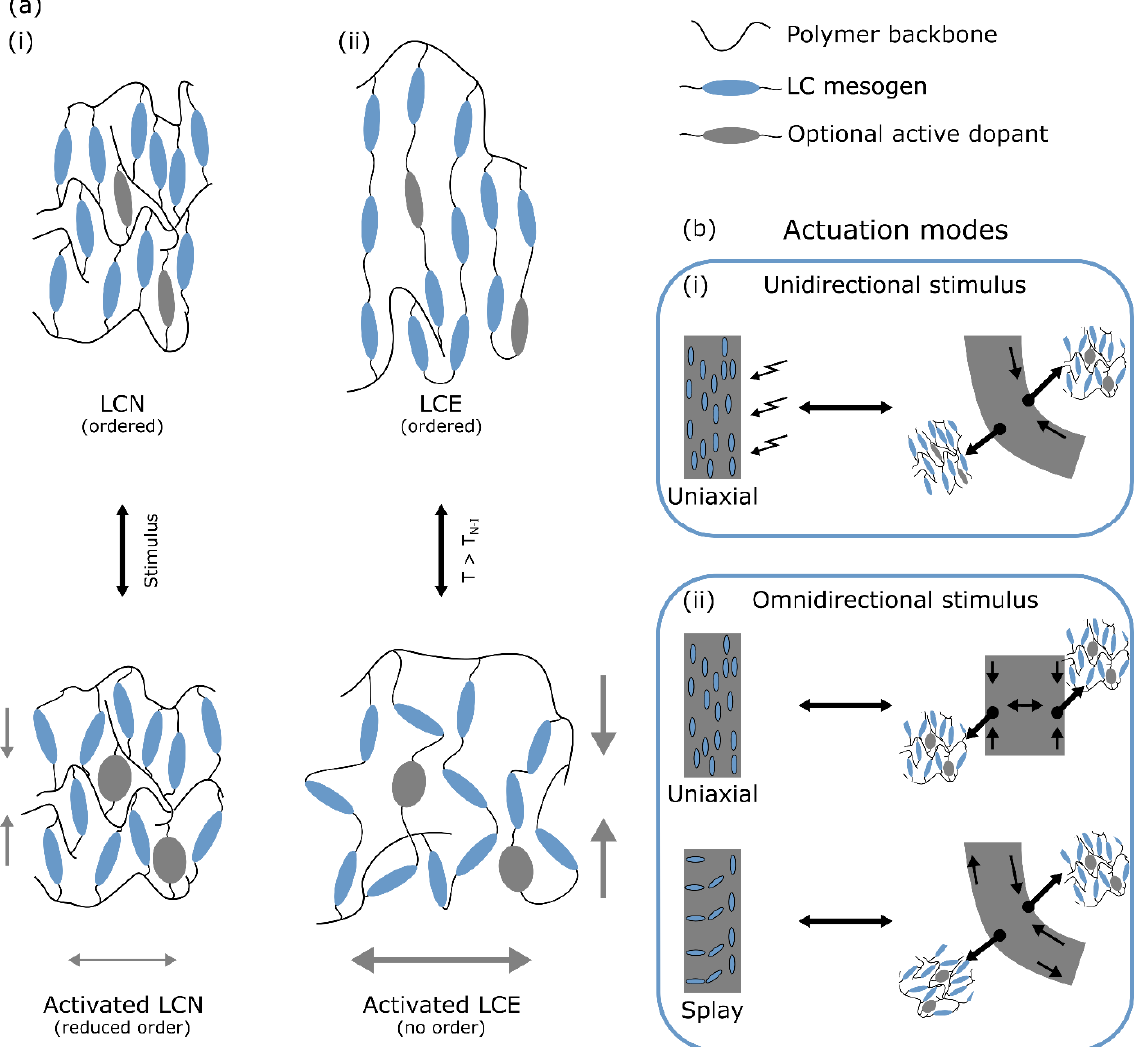
Figure 2. ( a ) Actuation mechanism of liquid crystal polymers on a molecular level triggered by a diversity of stimuli. ( i ) Homogeneously aligned liquid crystal networks show a uniaxial contraction along the alignment direction when disrupting the molecular order through an outside stimulus such as heat. The network expands in the directions orthogonal to the original LC director. Optionally, the network can be sensitised to other stimuli by incorporating active dopant molecules in the network structure. ( ii ) Liquid crystal elastomers are crosslinked less densely which makes a transition from the nematic to the isotropic phase possible. This reversible phase transition manifests as a strong contraction parallel to the molecular director and an expansion in the orthogonal directions. ( b ) Actuation of LC polymers on a device level. ( i ) Uniaxially aligned materials exposed to a